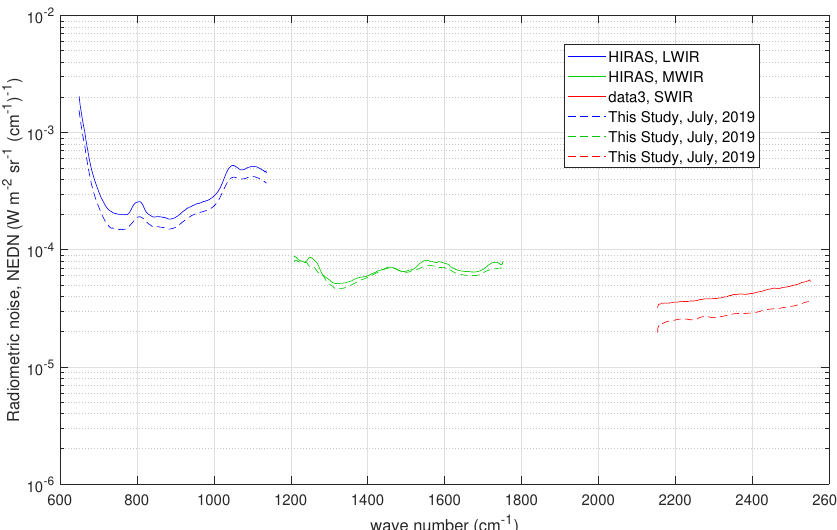
Figure 12. Results for the radiometric noise for the HIRAS instrument. The figure also shows the noise used for normalization, which in this case correspond to the HIRAS nominal radiometric noise shown in Figure 4. Results have been averaged over the four HIRAS pixels.